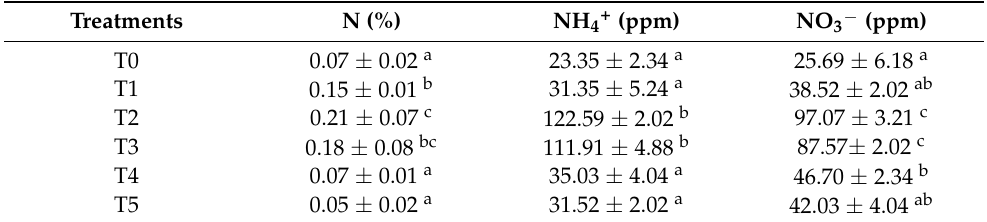
Table 6. Effects of rice straw and rice husk (RSRH) biochar on soil N, NH 4+ , and NO 3 − at harvest (70 days after transplantation (DAT)).